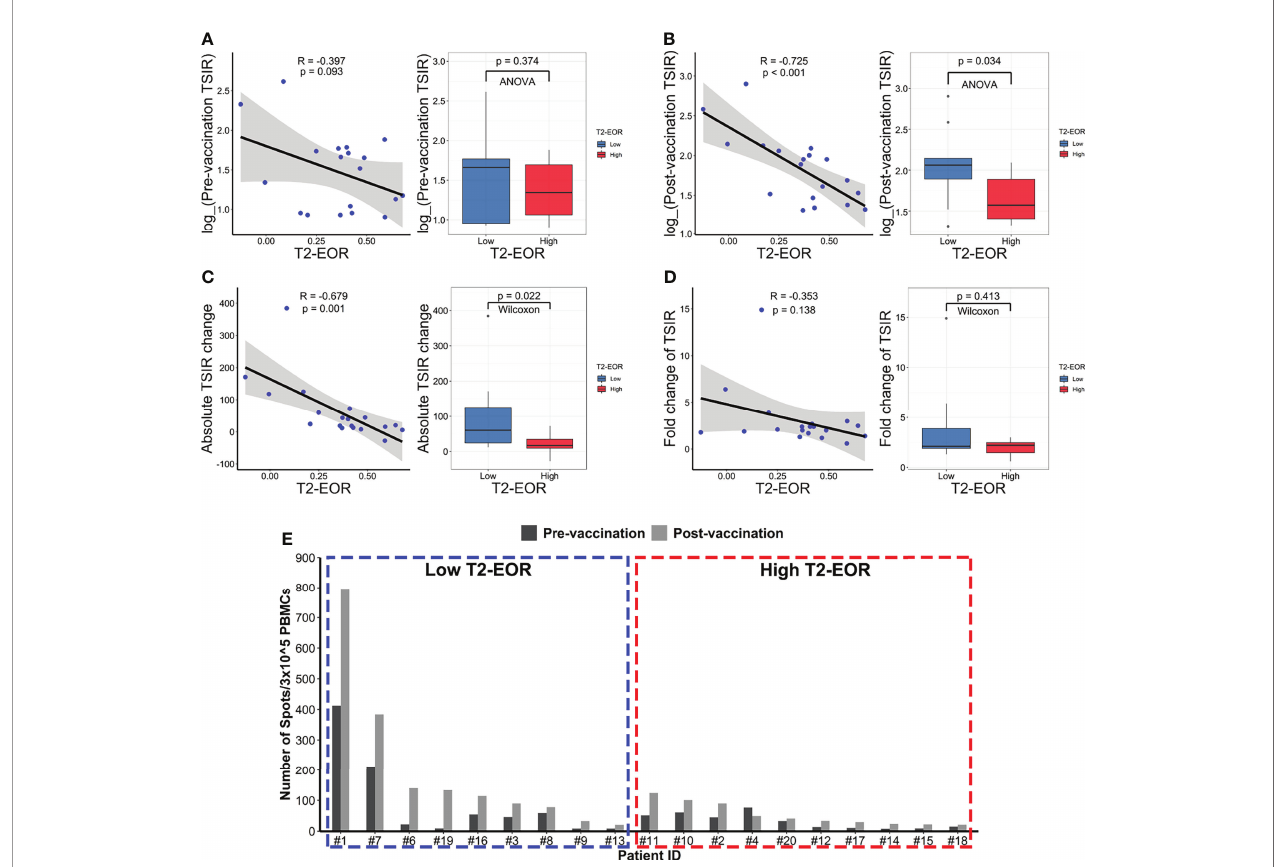
FIGURE 3 | T2-EOR was negatively correlated with the levels of the tumour-speci fi c immune response. Pearson correlation of T2-EOR with (A) pre-vaccination TSIR, (B) post-vaccination TSIR, (C) absolute change in TSIR from pre- to post-vaccination and (D) fold change in TSIR from pre- to post-vaccination. The differences in these TSIR indexes were also determined between the high and low T2-EOR groups using analysis of variance (ANOVA) or Wilcoxon nonparametric tests. (E) The levels of pre- and post-vaccination TSIR in each patient in this cohort are displayed as the high and low T2-EOR groups,